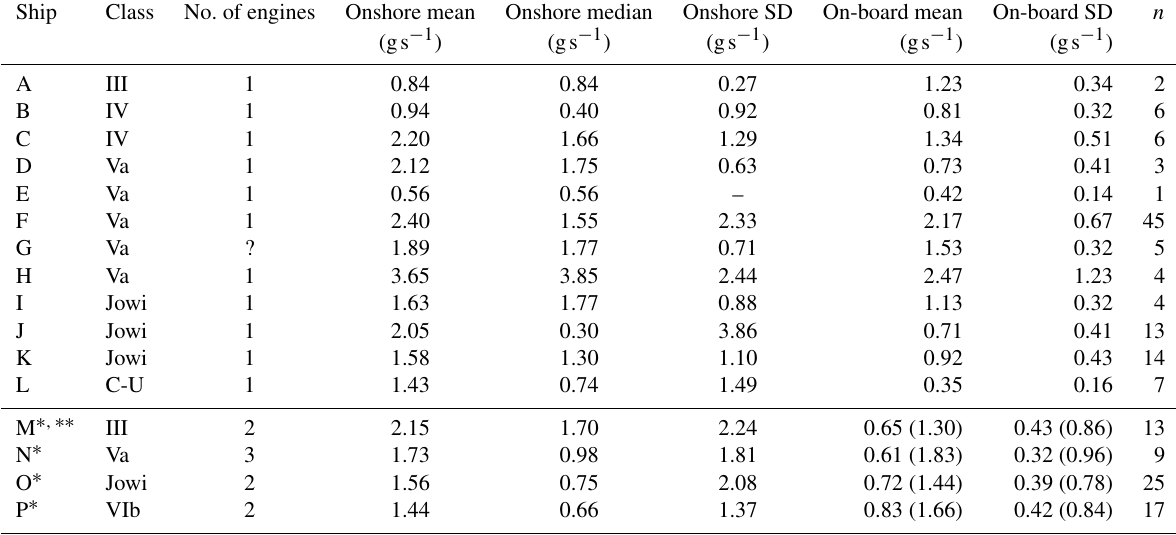
∗ Ships M, N, O, and P are equipped with more than one main engine used for navigation. It is assumed that the NO total emission rate for all main engines is therefore assumed to be the number of engines multiplied by the measured on-board emission rates (shown in parentheses). ∗∗